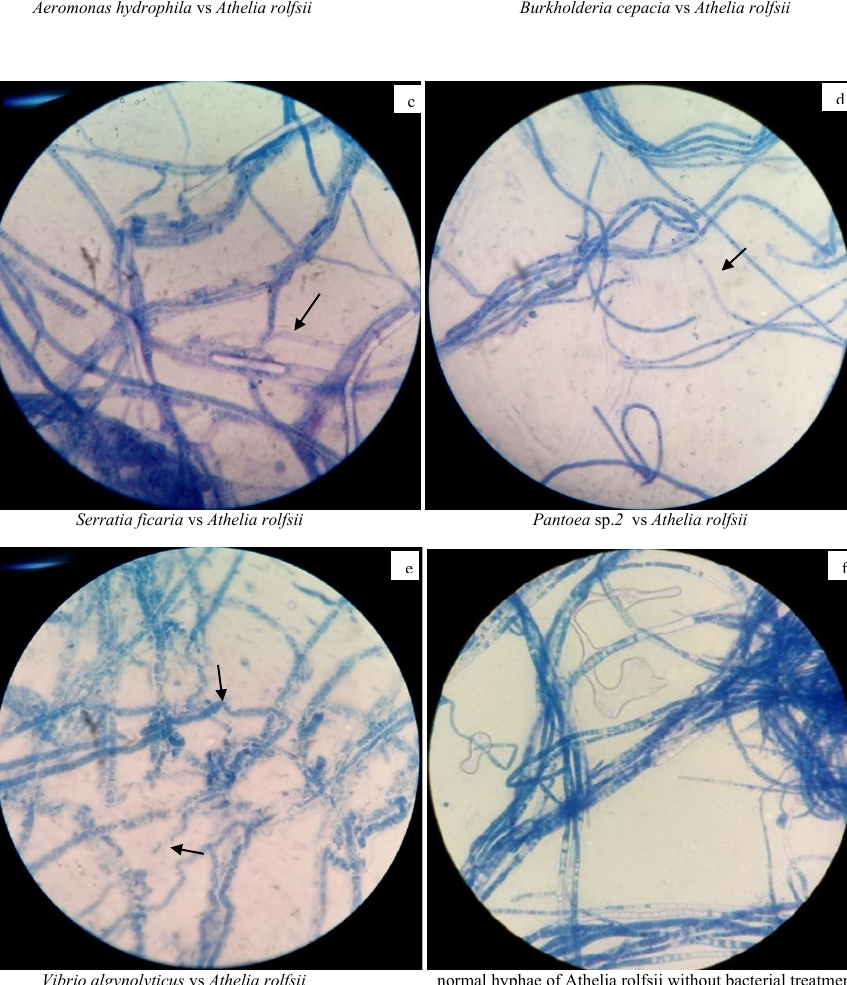
Figure 2: Microscopic observation of the in vitro antagonism of Plant Growth Promoting Rhizobacteria against Athelia rolfsii , a. crooked hyphae, b. shorten hyphae, c. lysed hyphae, d. lysed hyphae, e. lysed and crooked hyphae, f. normal